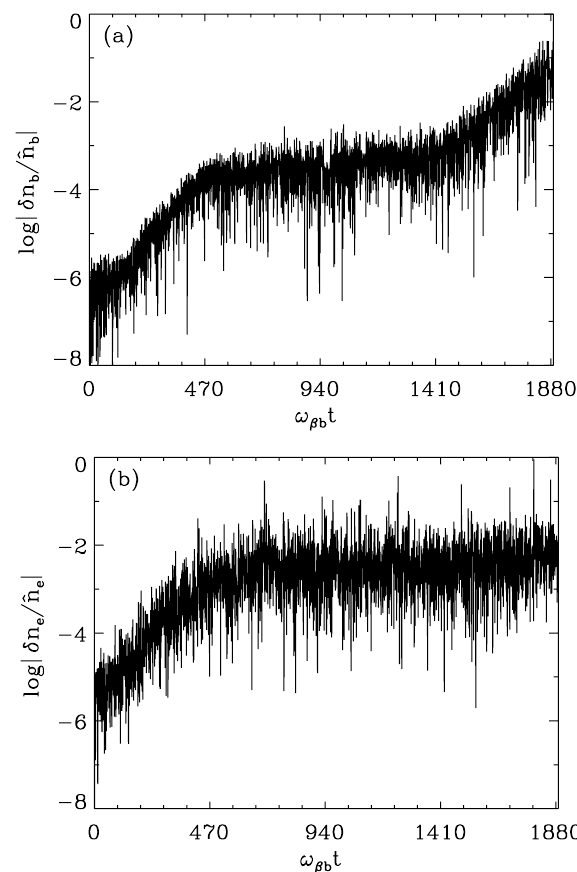
FIG. 3. Density threshold for the two-stream instability as a function of beam axial momentum spread for different values of fractional charge neutralization.